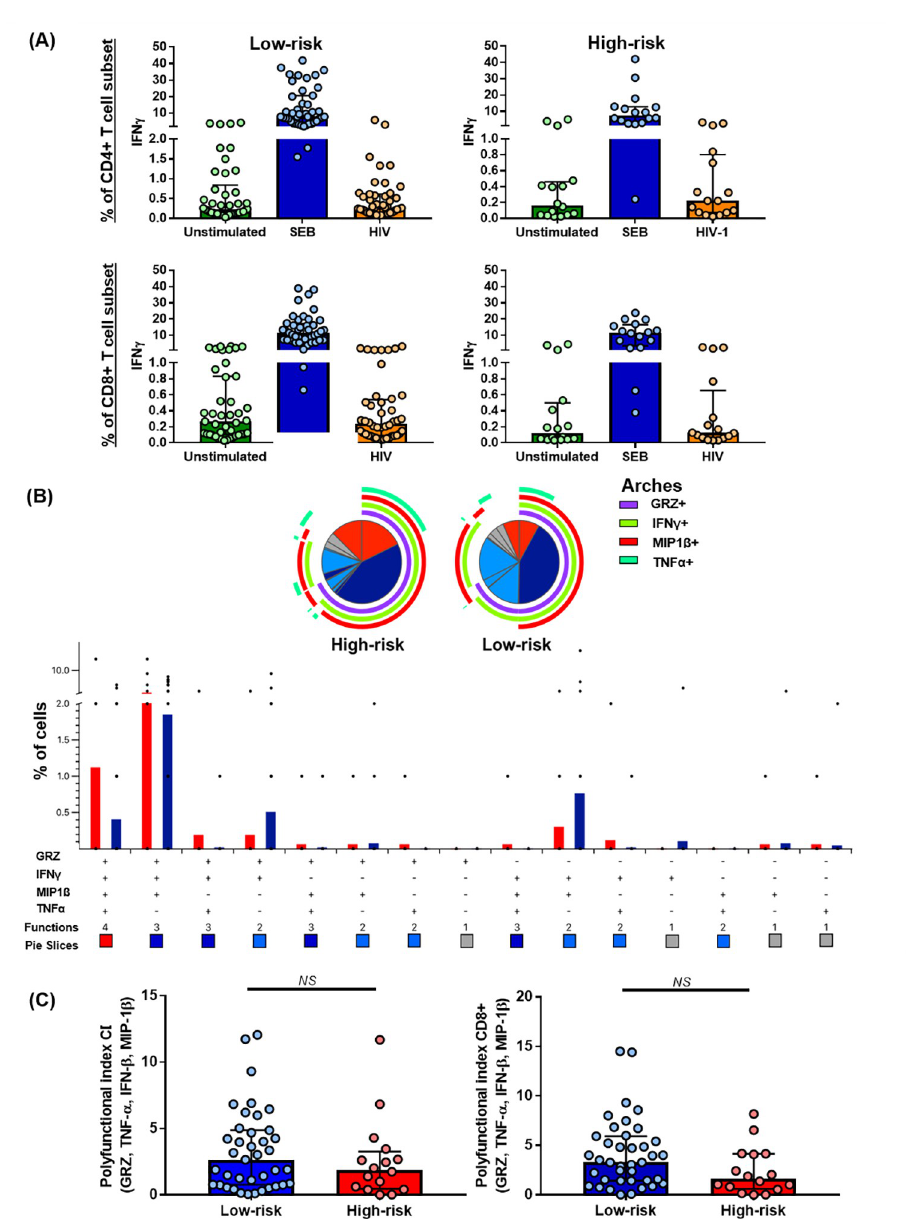
Fig 2. T cell responses against a pool of HIV-1 Gag peptides. (A) IFN- γ expression by unstimulated CD4+ and CD8 + T cells, or after SEB and HIV-1 Gag peptides stimulus. (B) Comparison of the polyfunctional profiles of Gag-specific responses in CD4+ T cells from both MSM groups. The slices of the pies correspond to the proportions of Gag-specific CD4+ T cells expressing 1 (grey), 2 (light blue), 3 (dark blue), or 4 (red) functions, until n simultaneous parameters (n + 1 dimensions) are calculated using the Boolean gating; the results are presented as mean. In the permutation analysis conducted in the SPICE platform, only data higher than 0.1% were included (after background subtraction). (C) INDEX of polyfunctionality (pINDEX) of CD4+ and CD8+ T cells from both MSM groups based on the proportions of cells producing intracellular combinations of Granzyme B, MIP1- β , TNF- α , and IFN- γ ; the pINDEX was calculated with Funky Cells software [31]; the comparison was performed with the Mann–Whitney U-test. For all the panels: high-risk group n = 16, low-risk group n = 44.